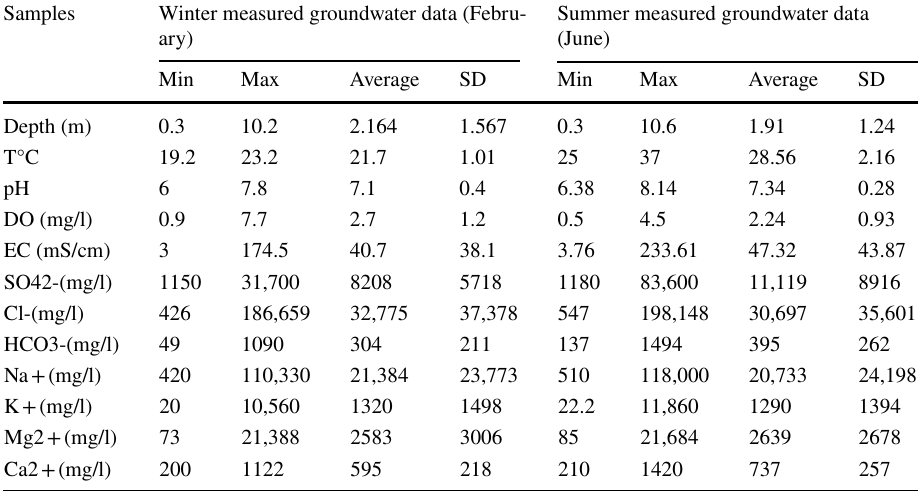
Table 1 Statistical summary of hydrochemical parameters